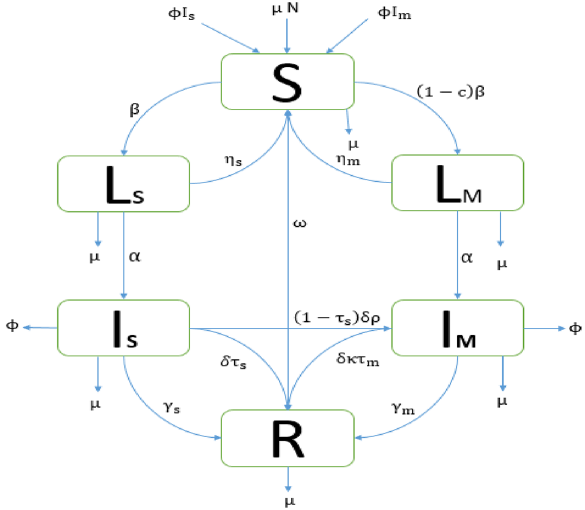
Figure 2. Schematic diagram of TB model for Bangladesh TB setting. System states and flow parameters are defined in the Methods section. Values for each of the model parameters can be found in Table